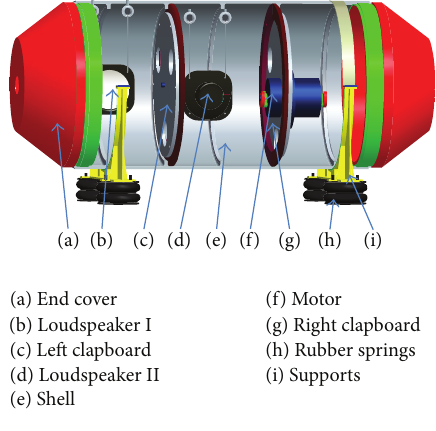
Figure 4: The structure of the test bed.